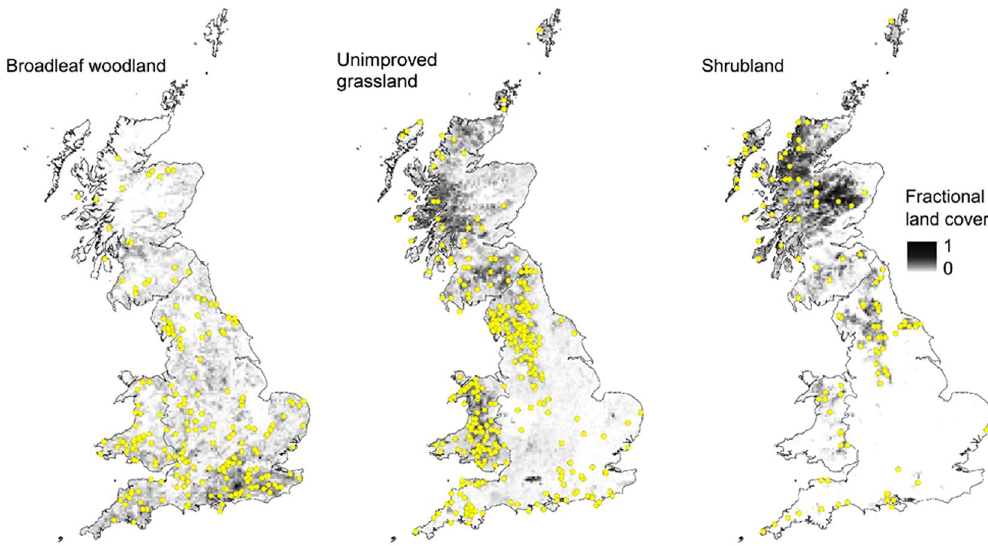
Figure 1. Maps showing the occurrence of the three semi-natural habitat types (grey scale) and sampling locations (circles). The fractional land cover refers to individual 5 km × 5 km grid cells used in simulation modelling. The maps were derived and plotted by aggregating land cover mapped at 25 m × 25 m resolution in the UK Land Cover Map 2007 33 , using ArcGIS 10.4 (http://desktop.arcgis.com/en/arcmap/) (accessed